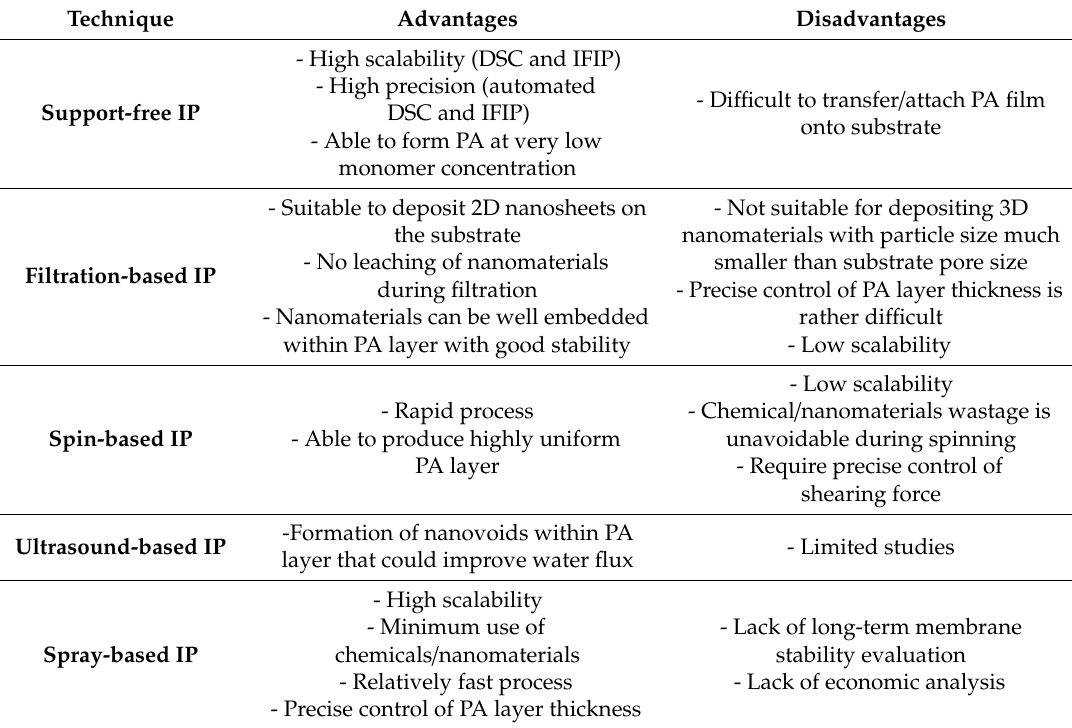
Table 8. Advantages and disadvantages of novel IP